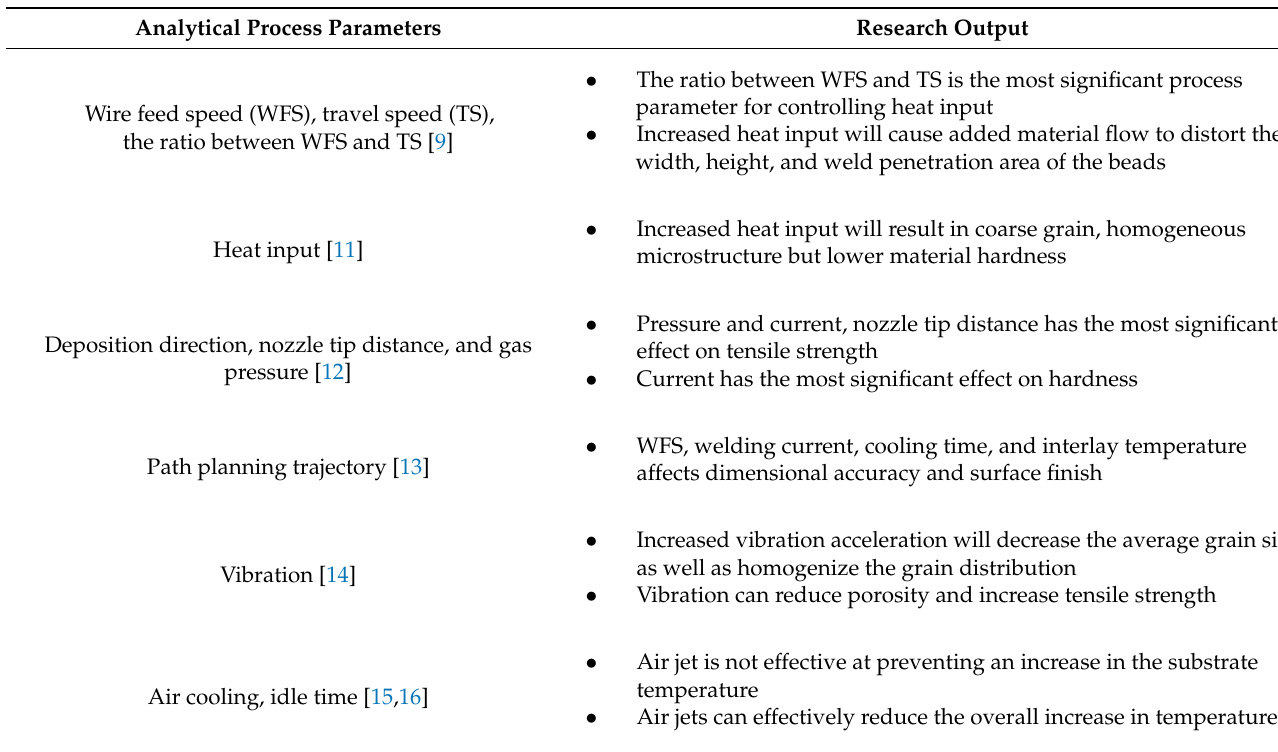
Table 1. Existing research on process parameters effect on build qualities.